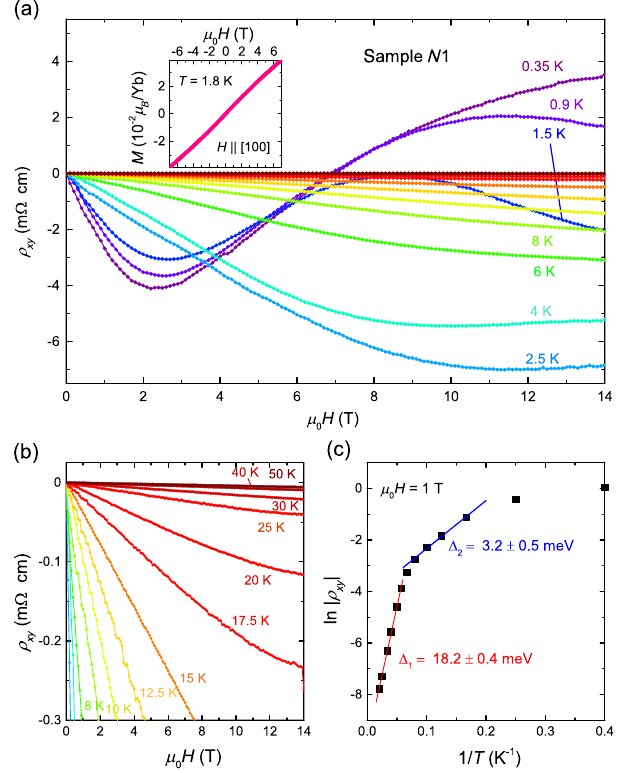
H Þ measured at temperatures ranging from 0.35 FIG. 2. (a) ρ xy ð to 50 K in the YbB 12 sample N 1 up to 14 T. The low-field anomaly becomes weaker above 0.9 K and completely disappears at 2.5 K. The negative Hall signal at higher temperatures indicates that electronlike carriers dominate. (Inset) Magnetization M of sample N 1 versus magnetic field H k½ 100 (cid:2) ranging from − 7 to þ 7 T at 1.8 K. The low-field M ð H Þ exhibits featureless and H Þ curves monotonic behavior. (b) Expanded view of the ρ xy ð measured at T > 15 K. (c) Arrhenius plot: ln j ρ at μ 0 H ¼ 1 T xy j plotted against 1 =T . The linear fits in the temperature ranges 20 K ≤ T ≤ 50 K and 6 K ≤ T ≤ 12 . 5 K yield Kondo gap widths Δ 1 ¼ 18 . 2 meV and Δ 2 ¼ 3 . 2 meV,